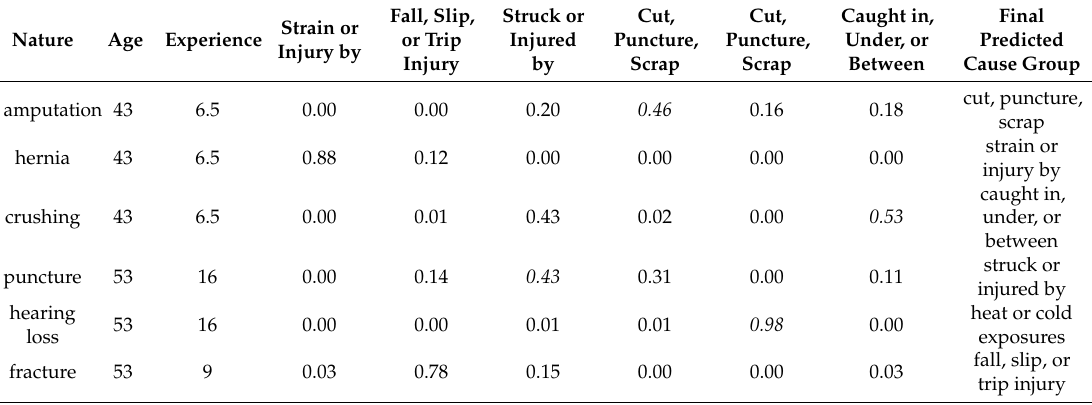
Table 8. Predicted cause group in grain elevator operations via probabilities from MLP